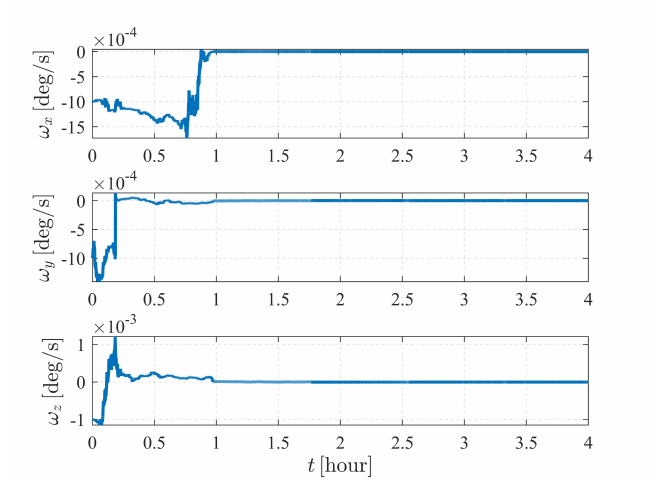
Figure 21. The estimation errors of angular velocity of case V (nonperturbation).